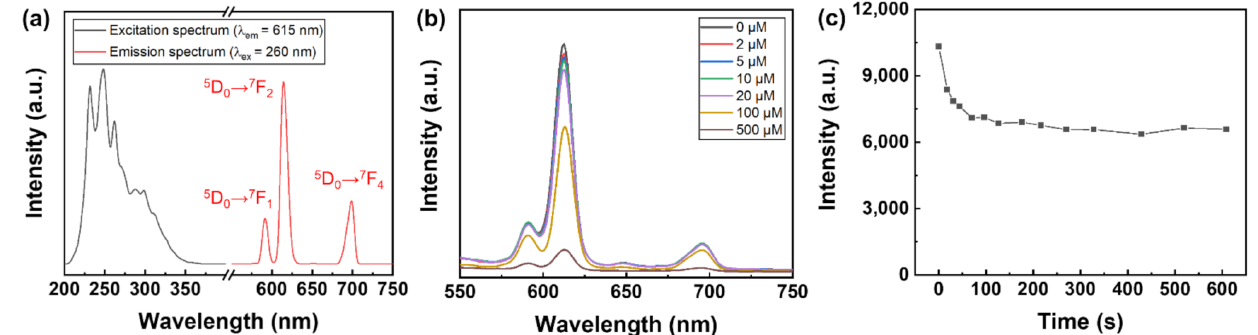
Figure 3. ( a ) Photoluminescence spectra of Eu-TCA dispersion. ( b ) Luminescence spectra of Eu- TCA dispersion in the presence of different amount of phosphate under the excitation at 260 nm. ( c ) Time-dependent luminescence intensity of Eu-TCA dispersion upon the addition of 100 µ M of